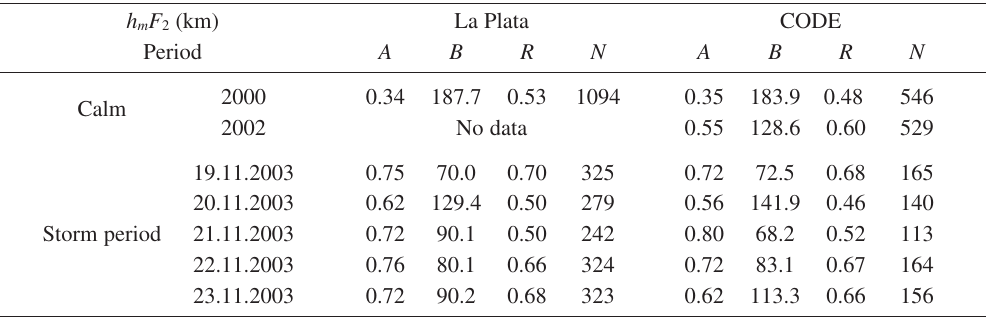
Table III. Linear regression fitting results for h m F 2 ( h m F 2 NeQuick = A ∗ h m F 2 Ionosonde + B ; R is the correlation coefficient and N the number of selected data). h m F 2 (km)